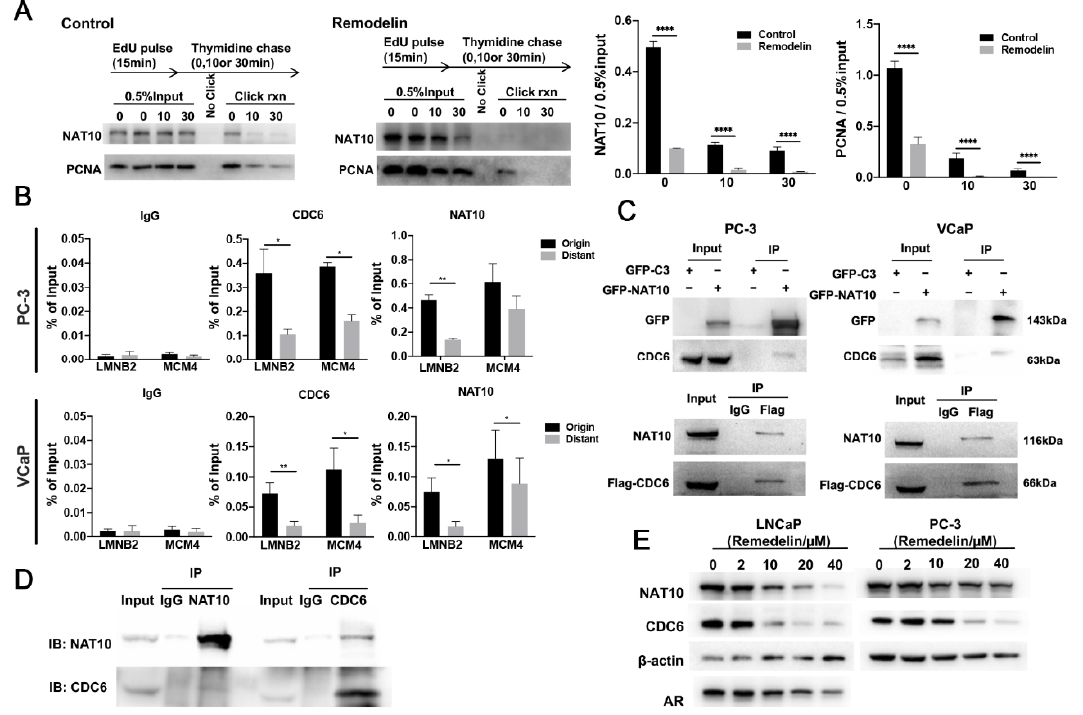
Figure 3. NAT10 is involved in the assembly of the DNA replication complex. ( A ) NAT10 binding to the nascent DNA. VCaP was pretreated with or without Remodelin for 12 h. After EdU (15 µ M) labeling of DNA for 15 min, thymidine chases were used for 0, 10, and 30 min. The proteins cross- linked with DNA were separated using iPOND technology, and then Western blotting was used for detection, followed by statistical analysis. T -test; ****, p < 0.0001. ( B ) NAT10 is specifically distributed at the origin of the DNA replication site. The DNA fragments that bind to the NAT10 and CDC6 proteins in the VCaP and PC-3 cells were extracted as templates, with the known proximal and distal sequences of the two replication sites of LMNB2 and MCM4 used for primer design. Real-time quantitative PCR was performed, and the results were analyzed. T -test; *, p < 0.05; **, p < 0.01. ( C , D ) NAT10 interacts with CDC6. ( C ) VCaP and PC-3 cells were exogenously transfected with GFP-NAT10 or Flag-CDC6, and protein immunoprecipitation was performed. ( D ) Endogenous immunoprecipitation of VCaP cells with NAT10 antibody and CDC6 antibody. ( E ) Downregulation of NAT10 reduced the levels of AR and CDC6. After Remodelin gradient concentration (0, 2, 10, 20, or 40 µ M) treatment, the levels of NAT10, AR and CDC6 in the PC-3 and LNCaP cells were measured by Western blotting, and statistics were performed. Representative images in each group are shown, and the data were quantified from triplicate experiments and are presented as the mean ±